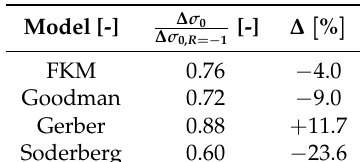
Table 3. Deviations ∆ between the estimated stress ranges by the different mean stress models and the experimentally evaluated data at R = 0.